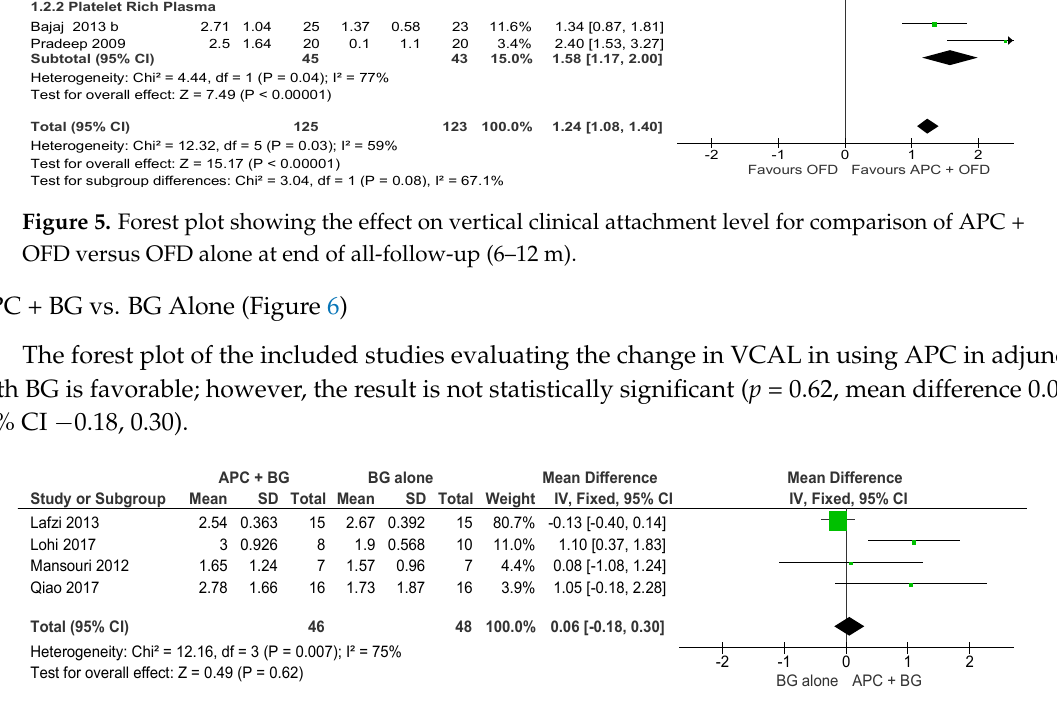
Figure 6. Forest plot showing the effect on vertical clinical attachment level for comparison of APC + BG versus BG alone at end of all-follow-up (6–12 m).